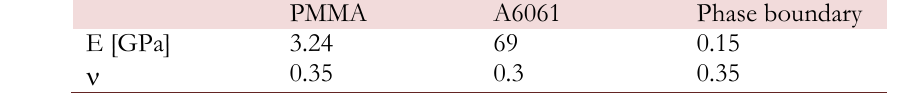
Table 2: Material